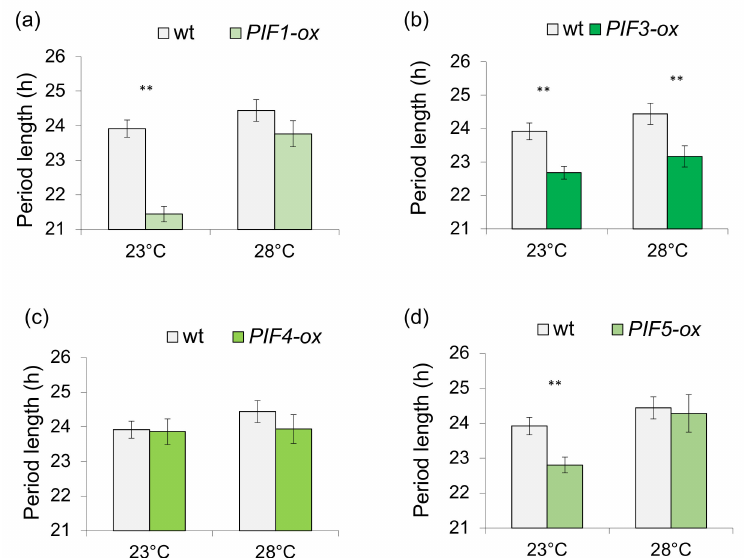
Figure 5. Circadian period of leaf movements of wt and PIF -overexpressing plants. Plants growing on 2% sucrose containing medium were entrained for 8 days at 14 h: 10 h, light: dark (100 µ molm − 2 s − 1 ) at 23 ◦ C before being transferred to constant white light (provided by fluorescent lamps; 50 µ molm − 2 s − 1 ; colour temperature 6500 K) at 23 ◦ C or 28 ◦ C. ( a ) PIF1 -ox, ( b ) PIF3- ox, ( c ) PIF4- ox, ( d ) PIF5- ox. Average of 2–3 biological repeats, n = 17–41. ** p < 0.01 (Student two-tailed t